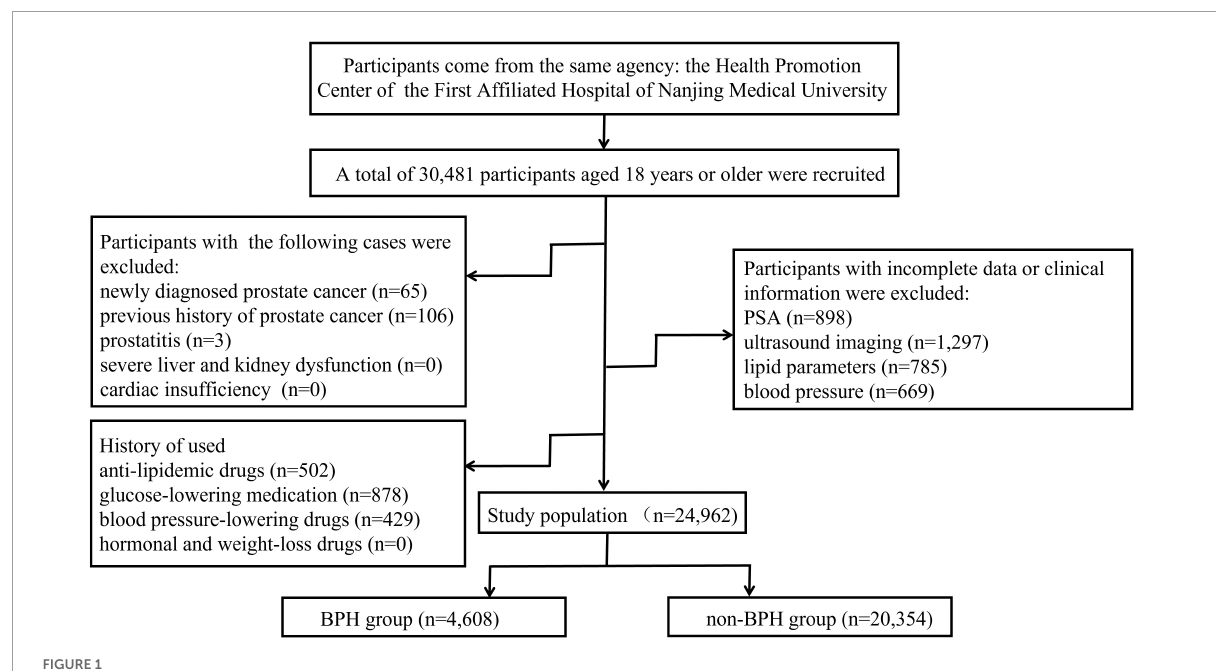
FIGURE1 Schematic diagram of the selection of study objects.